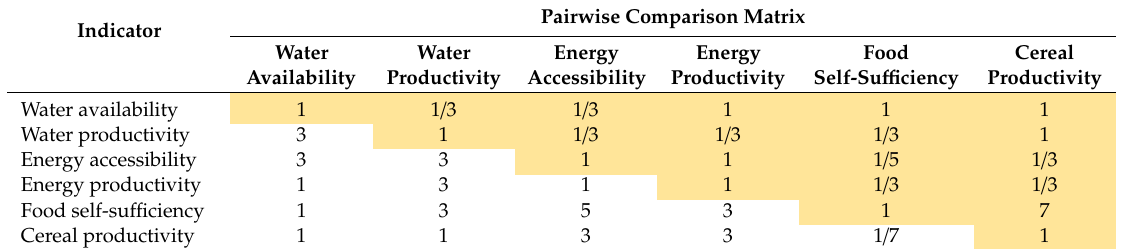
Table 3. Pairwise comparison matrix for the WEF nexus indicators for southern Africa. Pairwise Comparison